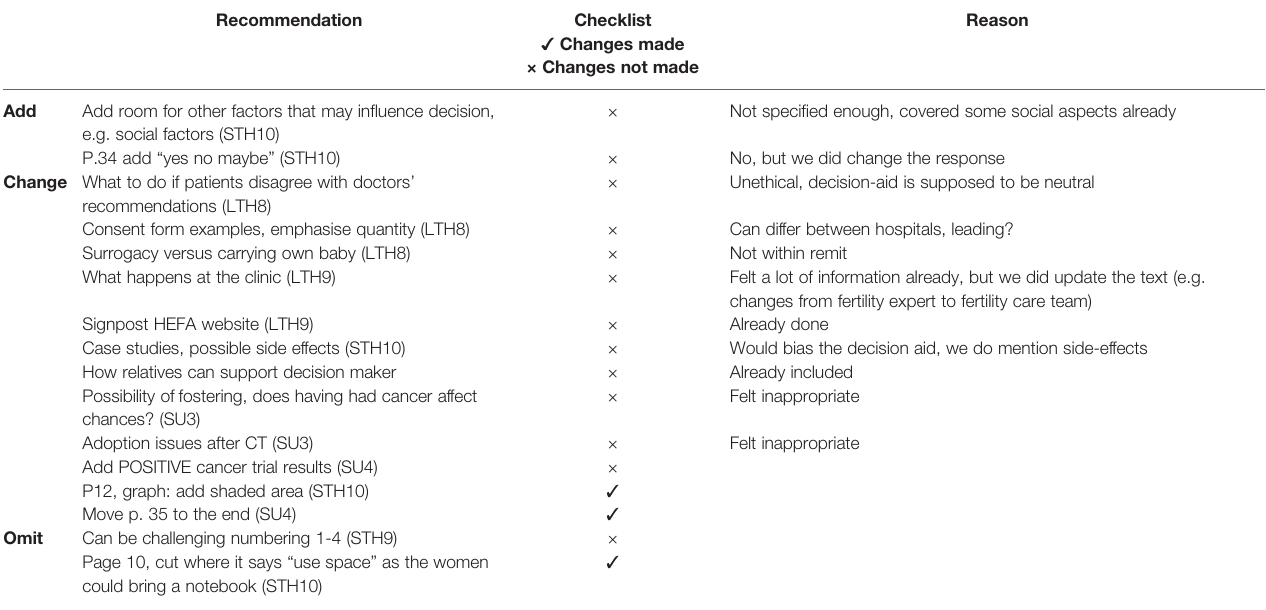
TABLE 4 | Practical recommendations made by patients following alpha